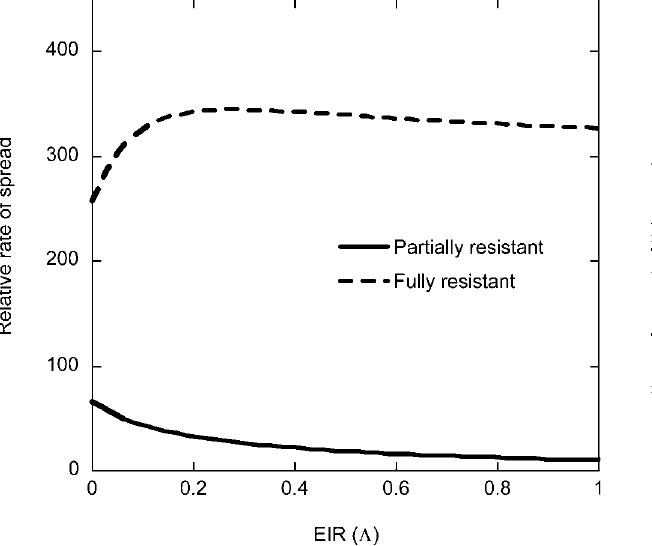
Figure 3. Effect of Increasing the Entomological Inoculation Rate ( K ) on the Percent Increase of R1 over RS or R2 over R1 Resistant Parasites DOI: 10.1371/journal.pmed.0030141.g003